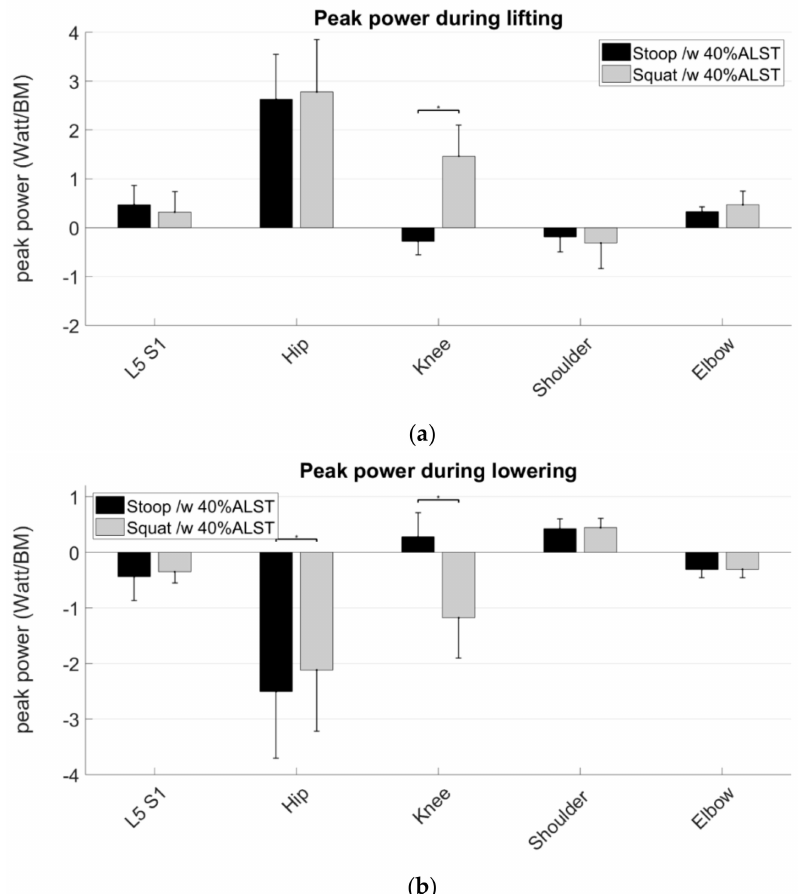
Figure 5. Peak power normalized to body mass during the two di ff erent lifting techniques (stoop and squat) with the load equal to 40% of the arm lifting strength test. Statistical significant di ff erences ( α < 0.05) between the handling phases are not indicated because the handling phase a ff ected peak power by inverting power generation and absorption in all conditions. Statistical meaningful di ff erences between technique and loads are indicated with one dot. Error bars indicate standard deviations. ( a ) Peak power during the lifting phase in the five di ff erent joints (L5S1, hip, knee, shoulder and elbow); ( b ) peak power during the lowering phase in the five di ff erent